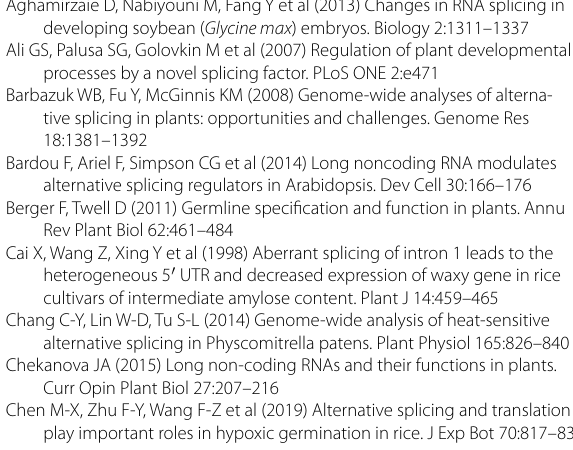
Additional file 2: Table S1 . Summary of the clean data. Table S2 . Sum- mary of the identified transcripts and genes, and its position. Table S3 . A